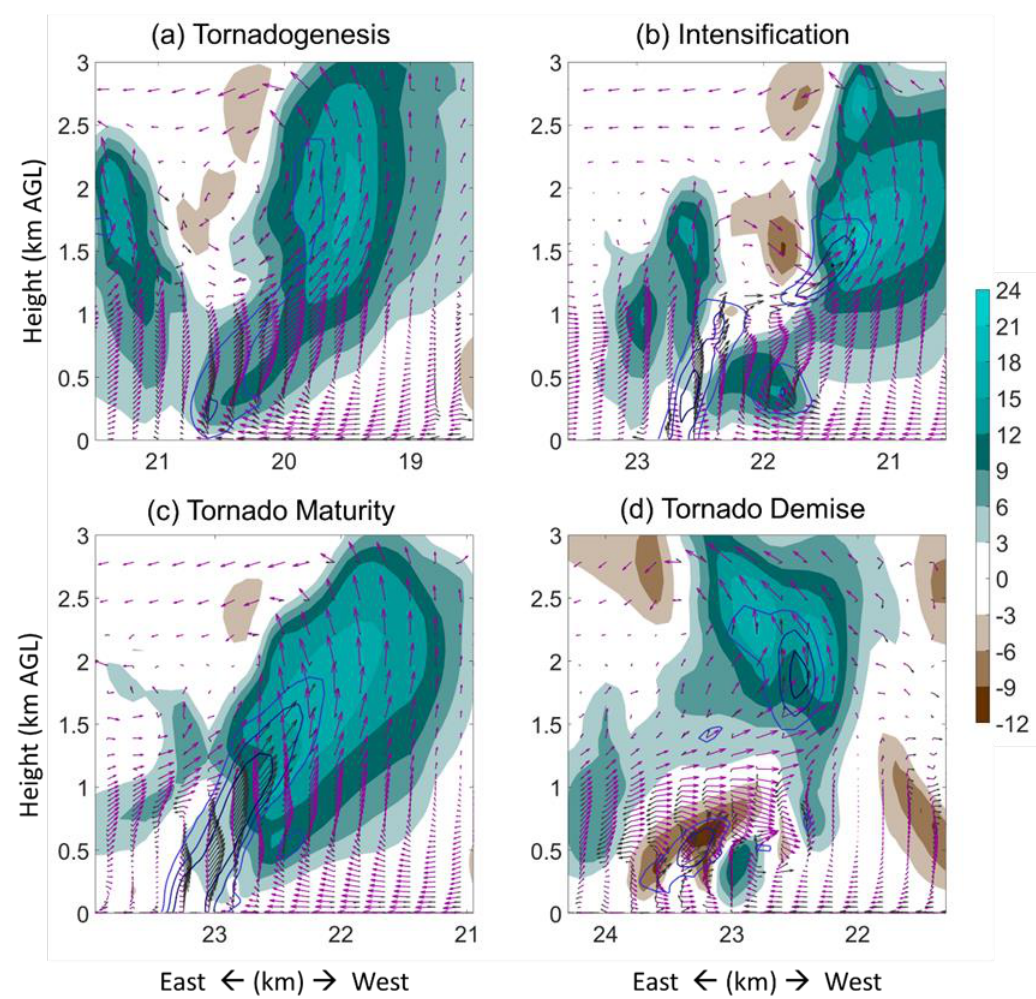
Figure 11. Vertical cross-section of the simulated supercell and tornado during the tornado lifecycle at range indicated by boxes in Figure 4, at the ( a ) tornadogenesis, ( b ) intensification, ( c ) maturity and ( d ) demise stages. Vertical velocity is given by shaded contours. Vertical vorticity of 0.05, 0.1 and 0.15 s − 1 is given by blue contours. Wind (vorticity) field is given by magenta (black) vectors.